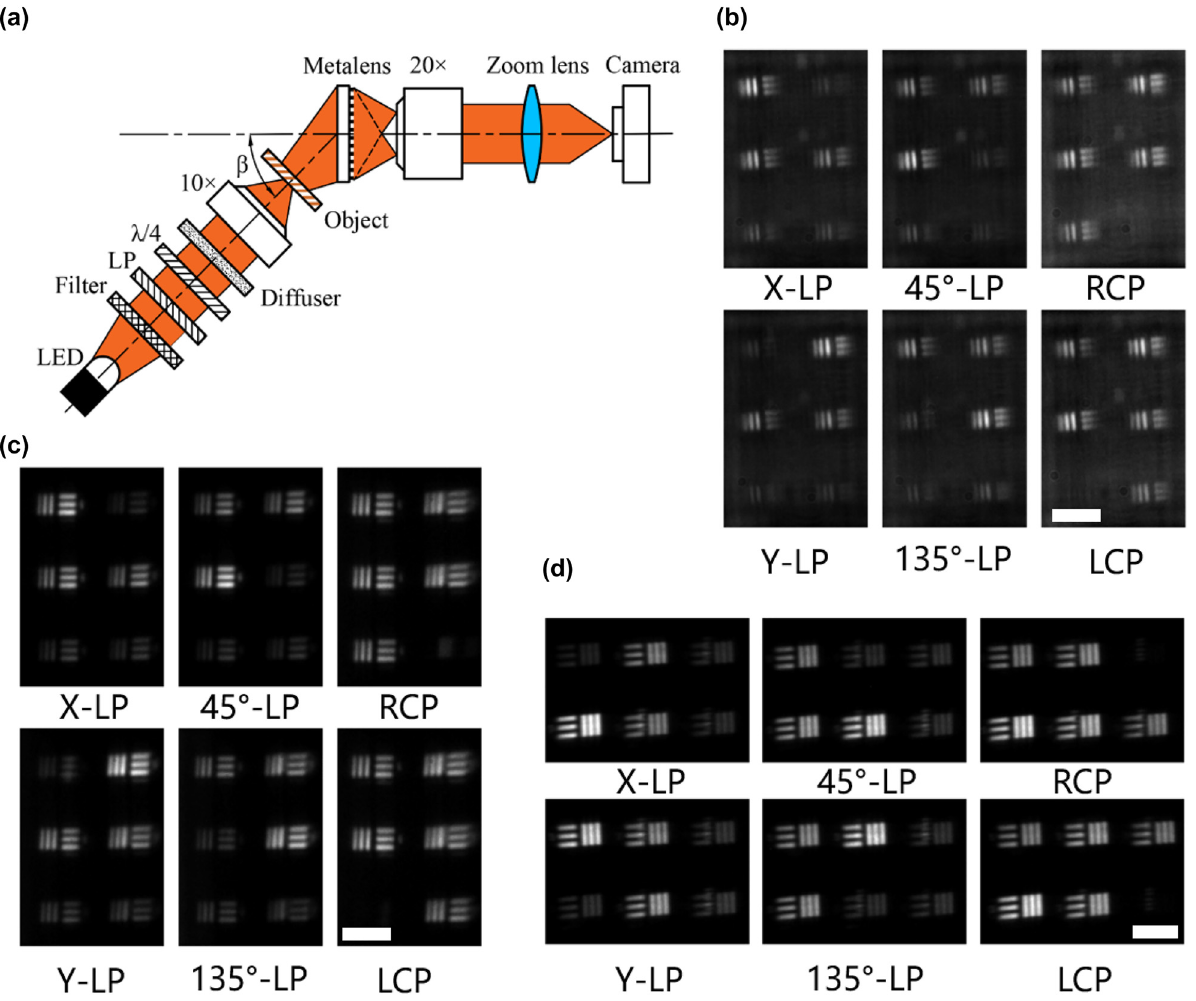
Figure 6: Experiment of polarization imaging by the BCEM. (a) Schematic diagram of the optical path used to test the imaging performance of the BCEM. (b)–(d) Full Stokes polarization imaging tests of sub eyes located at (0,0), (0,30), and (90,30), respectively. The results in (d) were tested with the BCEM rotated 90 ◦